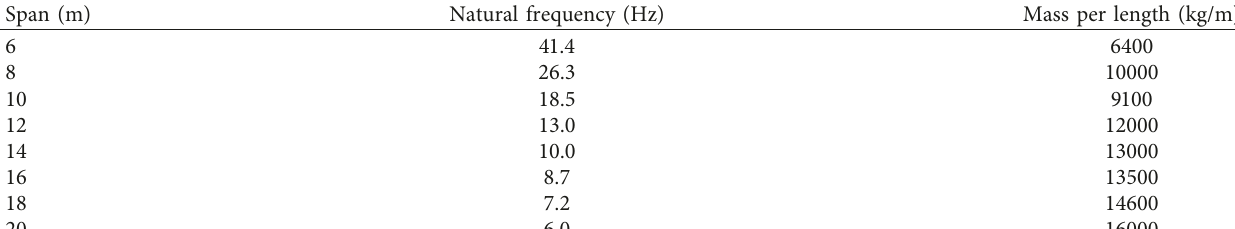
Table 3: Mechanical characteristics of the eight simply supported bridges.